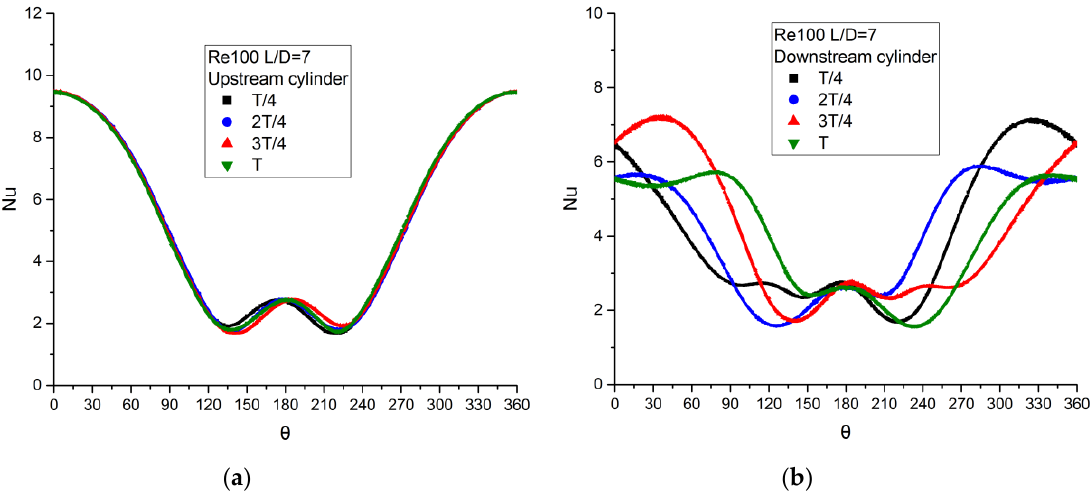
Figure 9. Transient Nusselt number distribution of the co-shedding pattern, Re = 100, L/D = 7: ( a ) 1/4T; ( b ) 2/4T; 3/4T; T; Nusselt number of the upstream cylinder; ( f ) Nusselt number of the downstream cylinder.